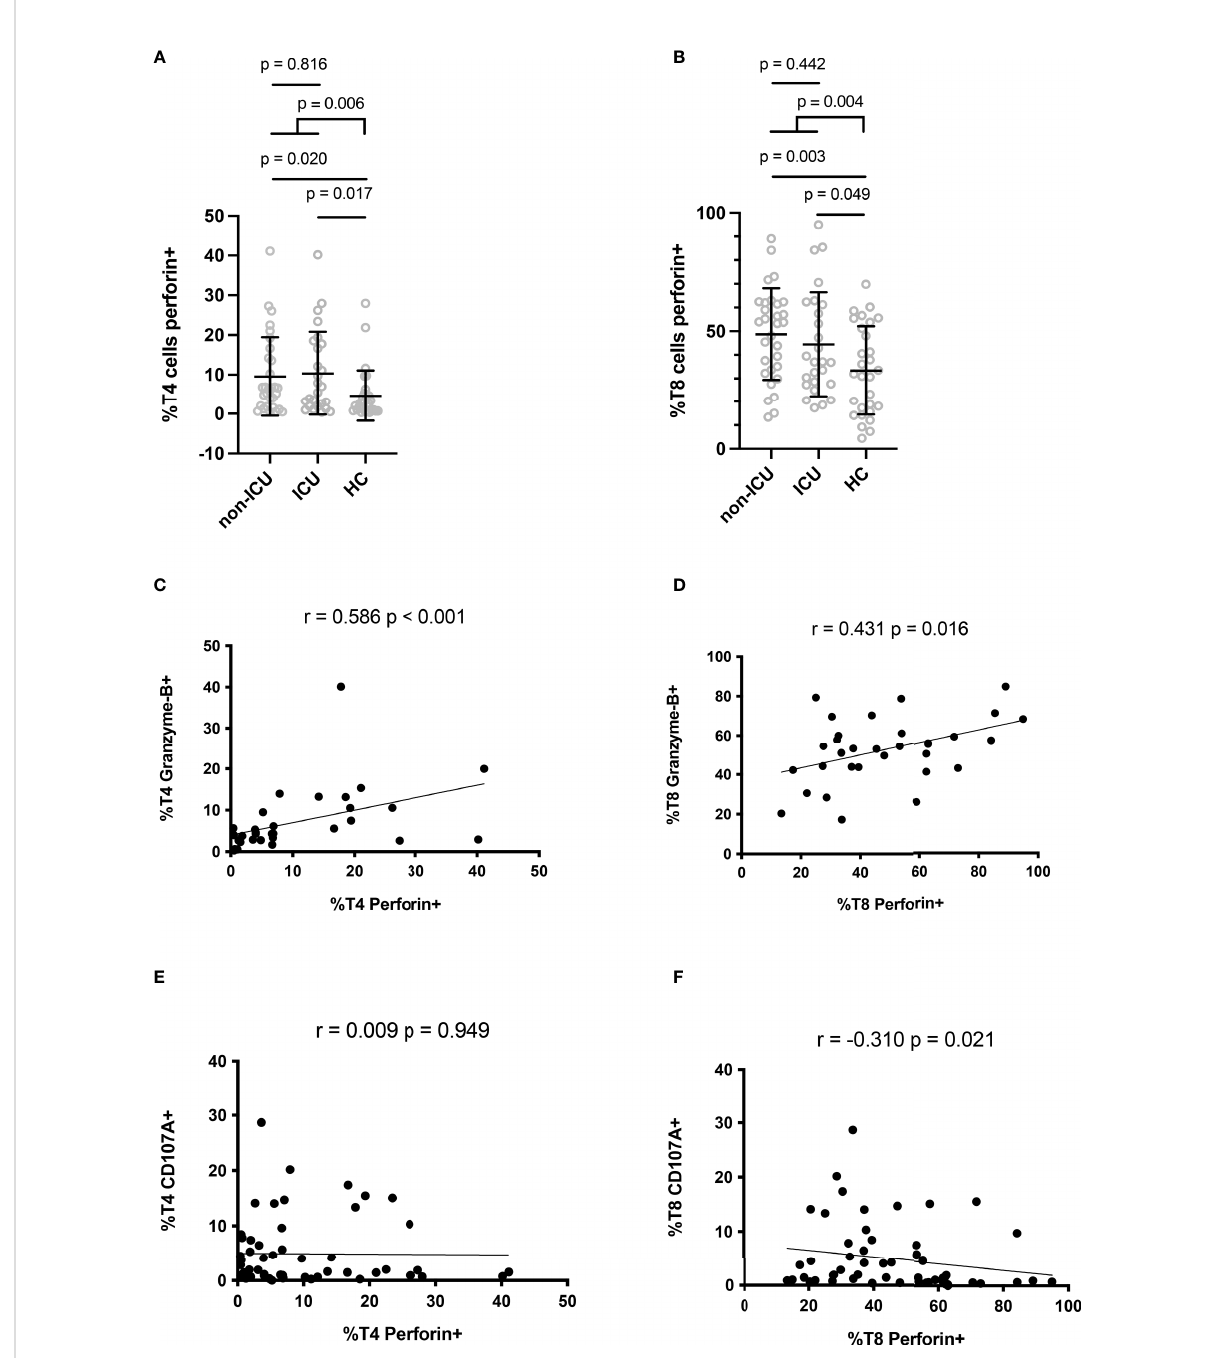
FIGURE 2 Perforin expression in CD4+ (A) and CD8+ (B) lymphocytes. Correlation between perforin and granzyme B expressions in CD4+ (C) and CD8+ (D) lymphocytes. Correlation between perforin and CD107A expressions in CD4+ (E) and CD8+ (F)